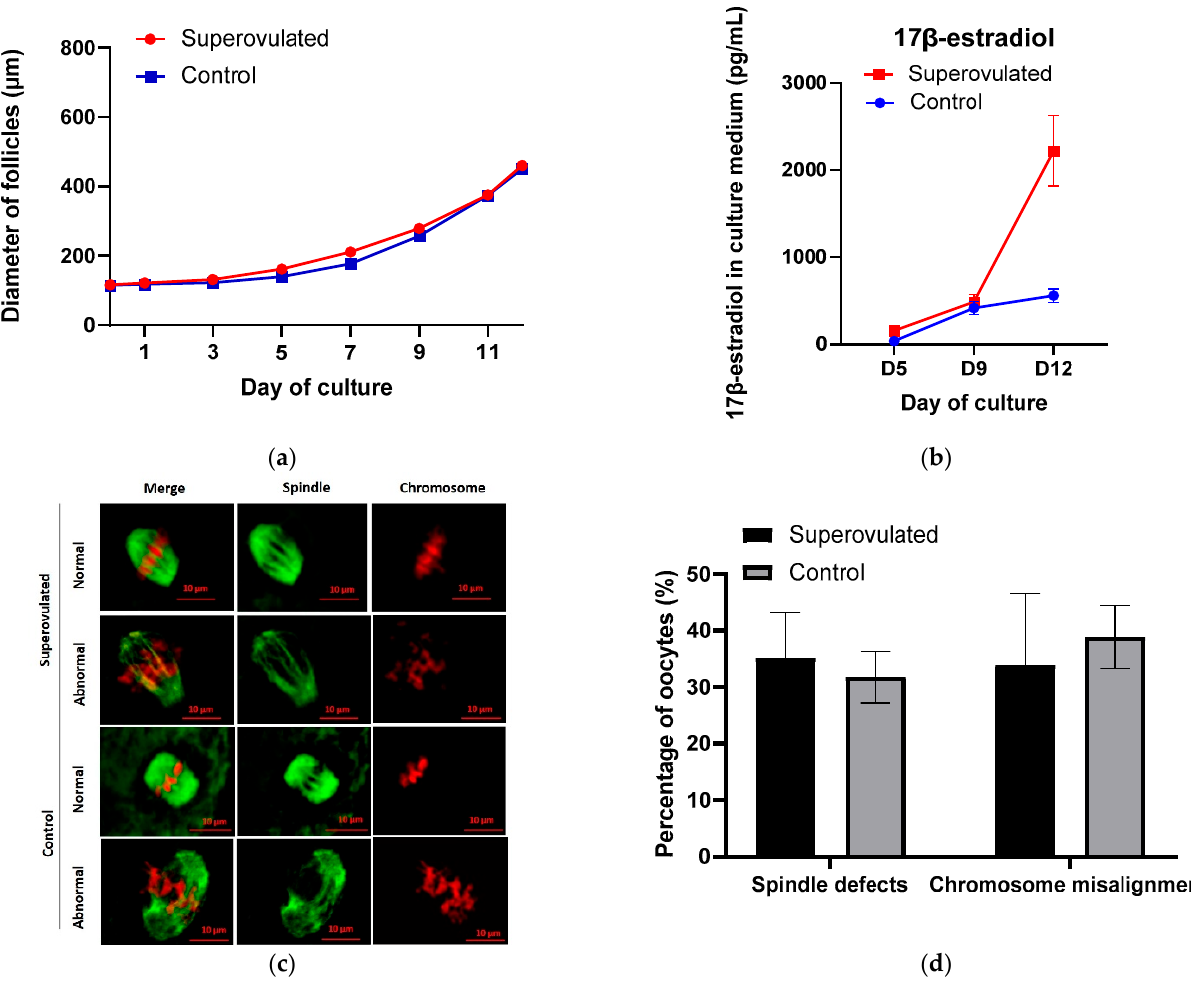
Figure 1. ( a ) Follicular growth curves during in-vitro culture; ( b ) 17 β -estradiol secreted by individual follicles in the culture medium; ( c ) Representative images showing a normal or abnormal morphology of spindle and chromosome configurations in MII oocytes from control and superovulated groups after IVM. Spindle fibers (green) were detected by immunofluorescence for a-tubulin, while DNA (red) was stained with propidium iodide. Scale bar, 10 µ m; ( d ) Percentages of MII oocytes with spindle defects or chromosome misalignment in control and superovulated groups. Table 2. Follicular sizes during culture (mean follicle diameter ± standard deviation, µ m) of follicles from superovulated ovaries vs. controls (** p < 0.01, *** p <